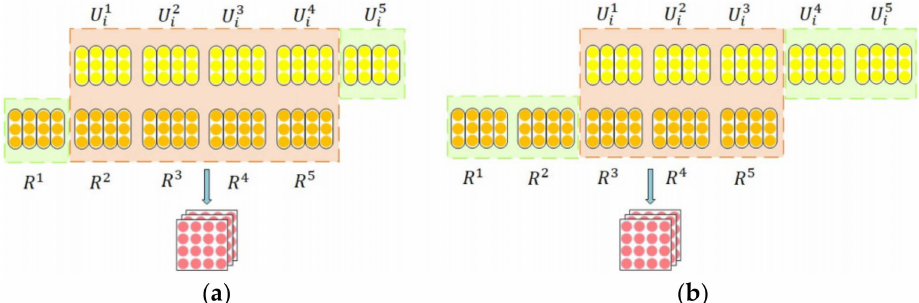
Figure 2. Shifted granularity matching module in full matching. ( a ) a fully matched model when the dislocation distance is 1, that is, matching the representation of the 5th level granularity of utterance (green box) with the representation of the 1st level granularity of response. ( b ) a fully matched model when the dislocation distance is 2, matching the granularity representations of the 4th and 5th levels of utterance with the granularity representations of the 1st and 2nd levels of response, respectively. The green boxes on either side indicate head-to-tail granularity matching to achieve full